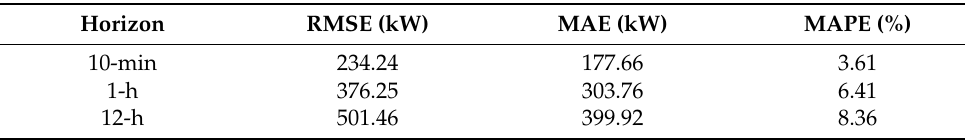
Table 6. Summary of the adjusted models for the three horizons.